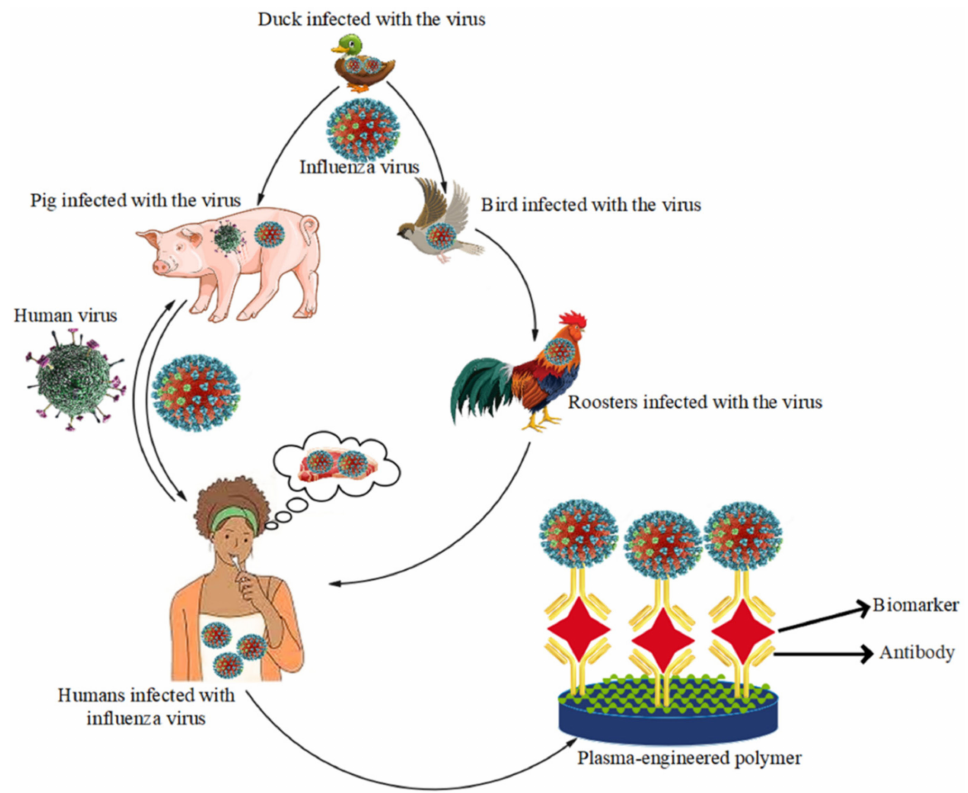
Figure 9. Detection of influenza virus by plasma-engineered polymer-based